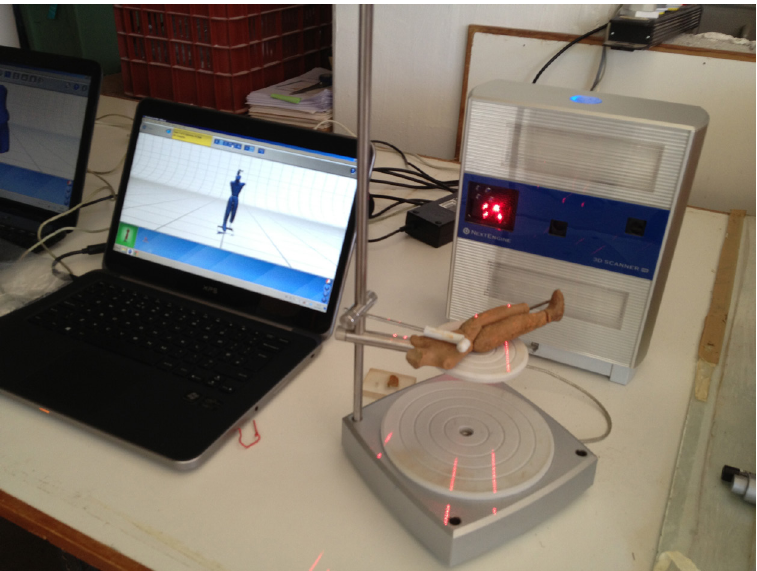
Figure 1. Figurine held in position for scanning on the rotating